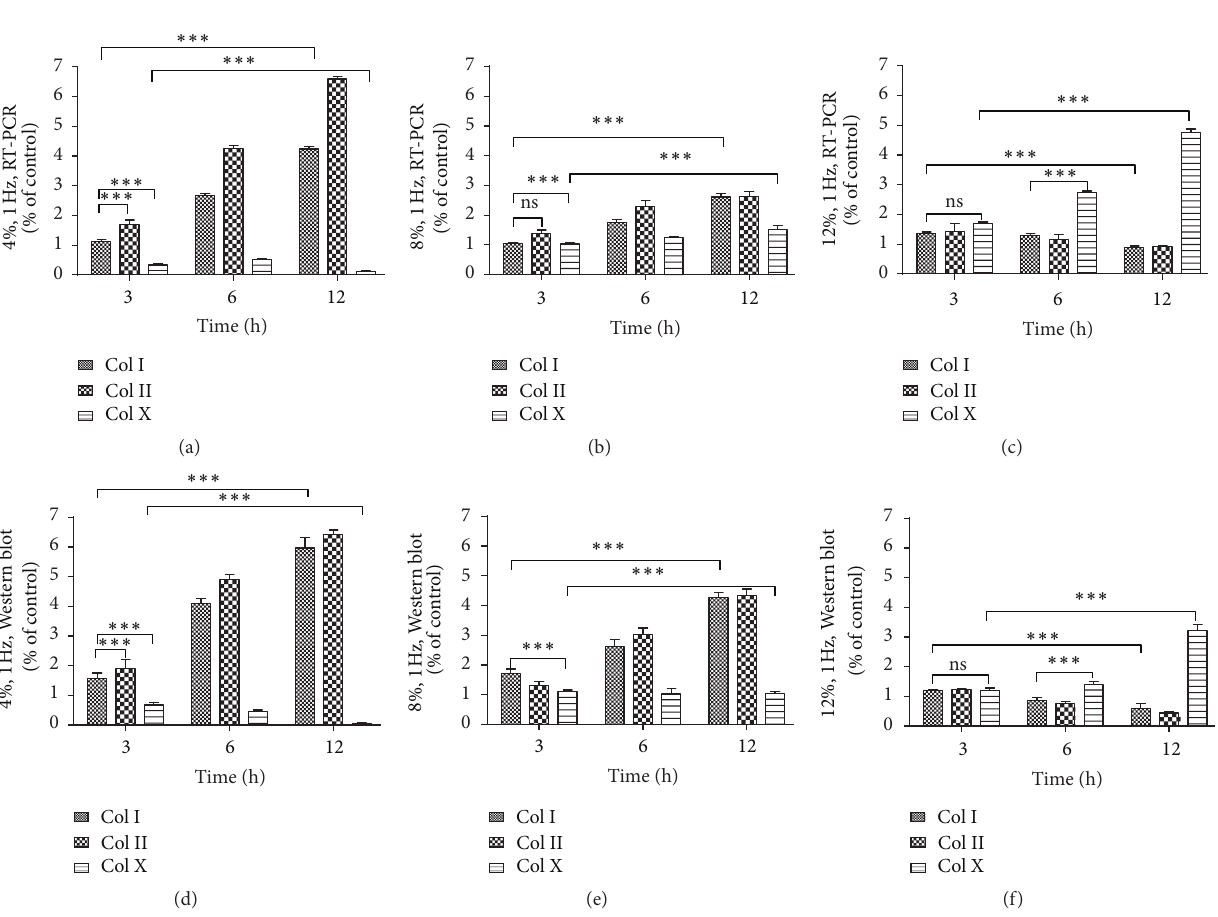
PTHrP precisely regulate the growth of long bone through a feedback regulatory mechanism [23,